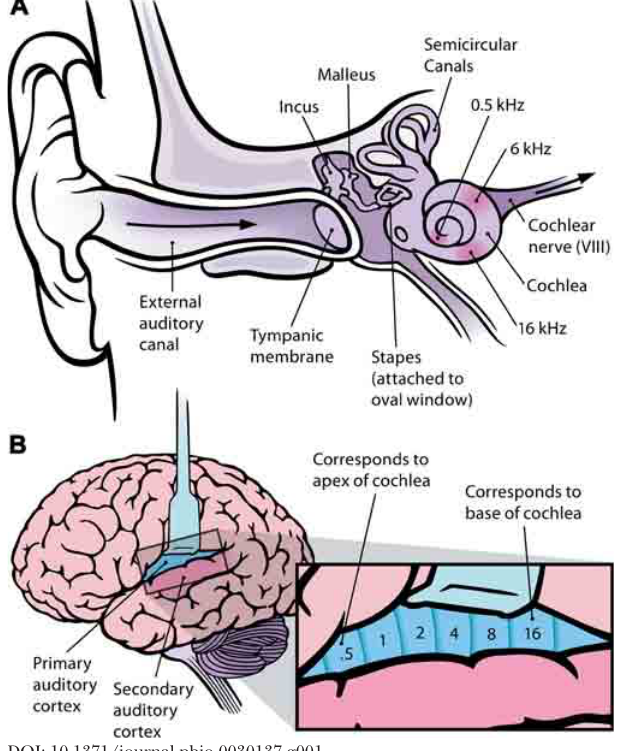
Figure 1. Frequency Coding in the Human Ear and Cortex (A) The human ear and frequency mapping in the cochlea. The three ossicles incus, malleus, and stapes transmit airborne vibration from the tympanic membrane to the oval window at the base of the cochlea. Because of the mechanical properties of the basilar membrane within the snail-shaped cochlea, high frequencies will produce a vibration peak near the oval window, whereas low frequencies will stimulate receptors near the apex of the cochlea (locations for three frequencies indicated schematically). Information from the cochlear receptor cells is transmitted to the cochlear nuclei via the 8th cranial nerve, and on through the midbrain to the cortex. (Redrawn from Figure 12.3 in [11].) (B) Lateral view of the human brain, with the auditory cortex exposed. The primary auditory cortex contains a topographic map of the cochlear frequency spectrum (shown in kilohertz). (Redrawn from Figure 12.15A in